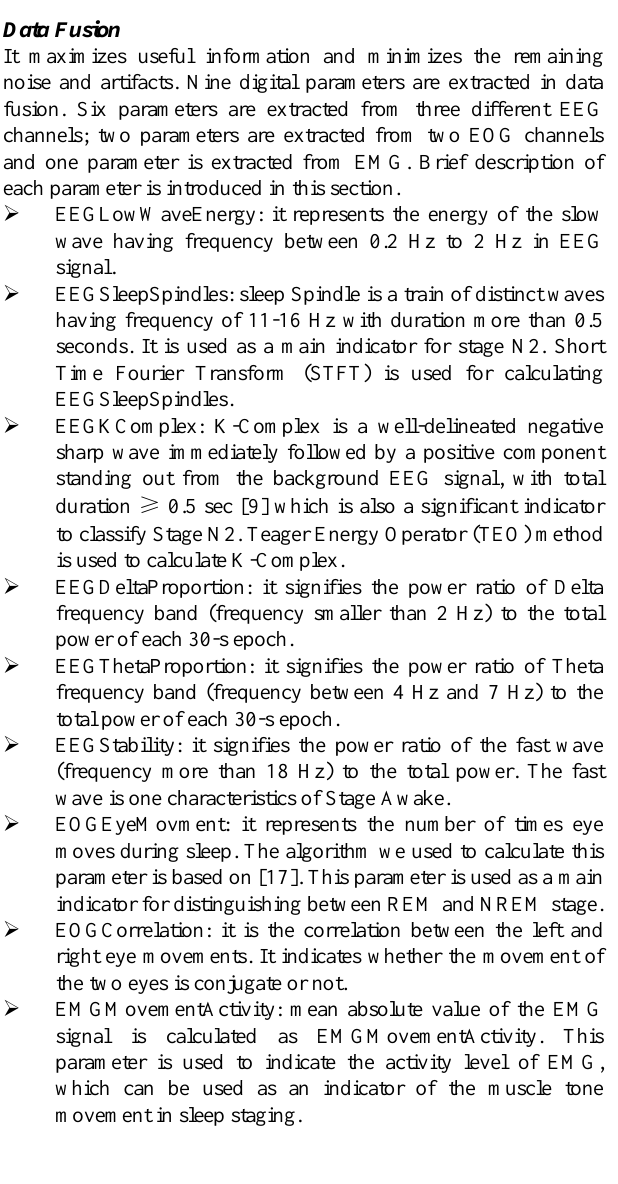
Figure 2. Symbolic fusion design